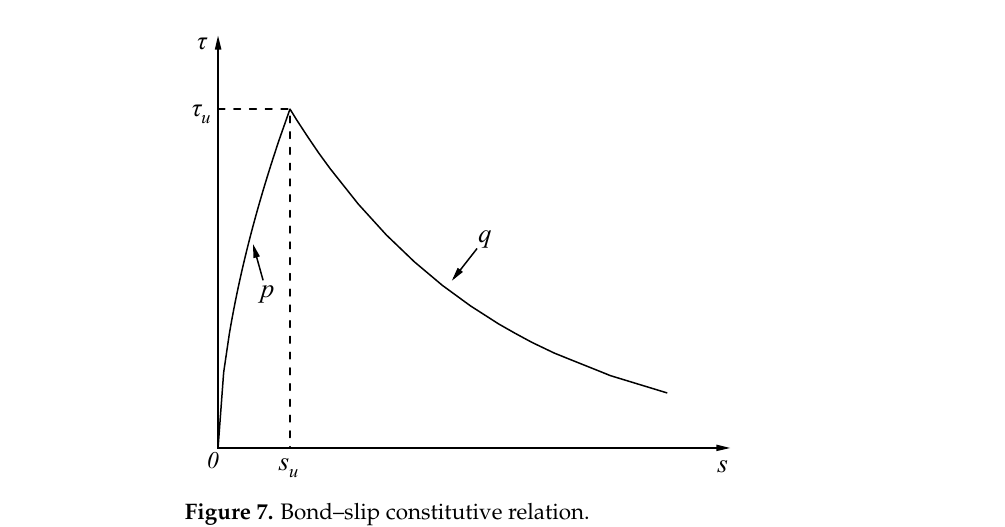
( f ) Figure 6. Comparison of bond strength between test values and formula values: ( a ) Alkaysi; ( b ) Roy; ( c ) Sturm; ( d ) Marchand; ( e ) Ma; ( f ) Fang. Through the above comparison results, the empirical equation of bond strength in reference [30] is selected: (1 0.55 / )(1 0.22 / 0.22